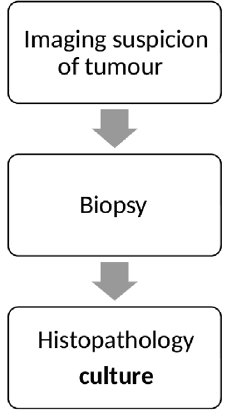
Figure 1. Simple fl owchart of the diagnostic protocol to con fi rm